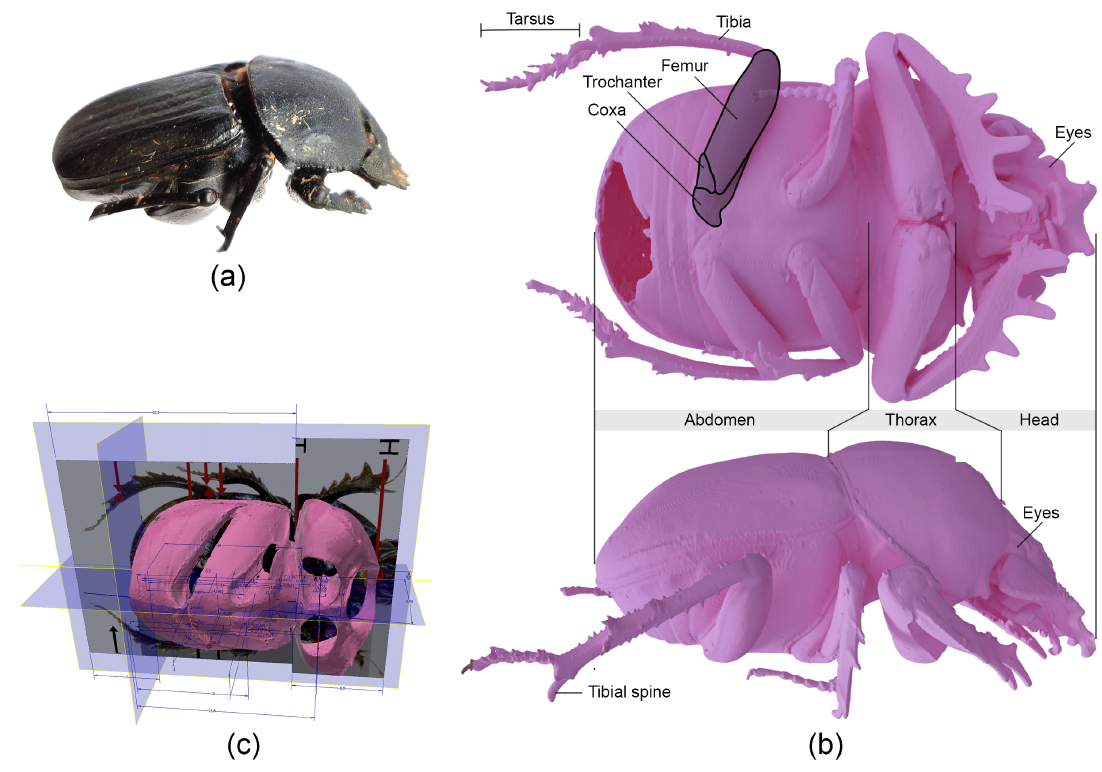
Figure 4. Side view of dung beetle Scarabaeus galenus ( a ), Initial full µ CT scan of the dung beetle ( b )